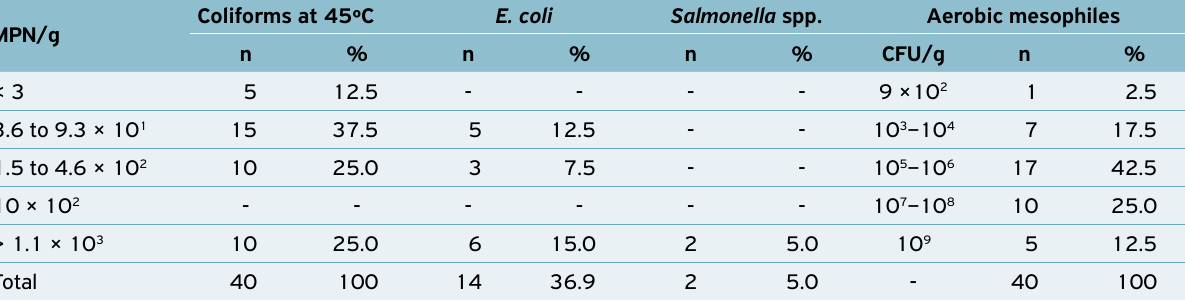
Table 1. Number and percentage of trahira ( H. malabaricus ) samples contaminated by coliforms at 45ºC, E. coli , Salmonella spp. and aerobic mesophiles. São Bento,